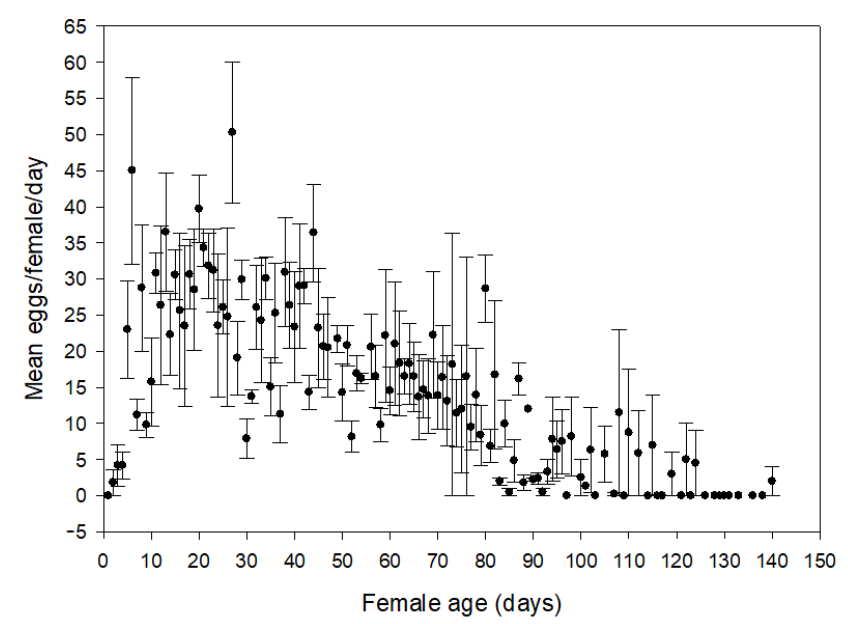
Figure 1. Lifetime egg production of Lysathia flavipes females ( n = 15) on Ludwigia hexapetala .